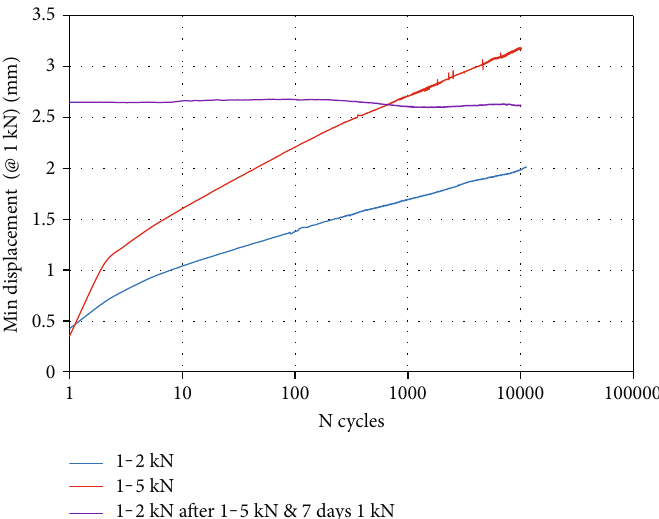
Figure 10: Ratcheting test results in di ff erent loading sequences.